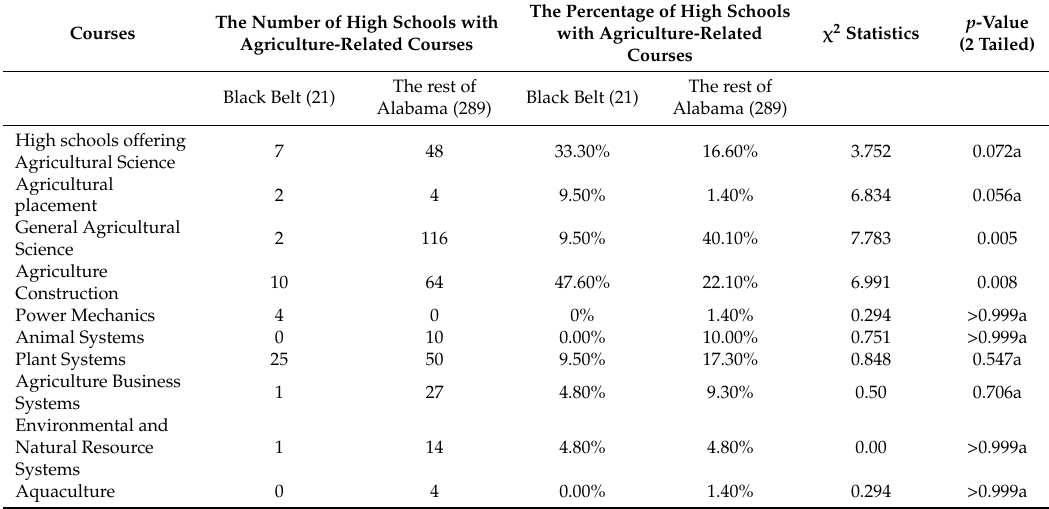
Table 3. The prevalence of courses related to agriculture in high schools in Alabama’s Black Belt area in comparison with the rest of the